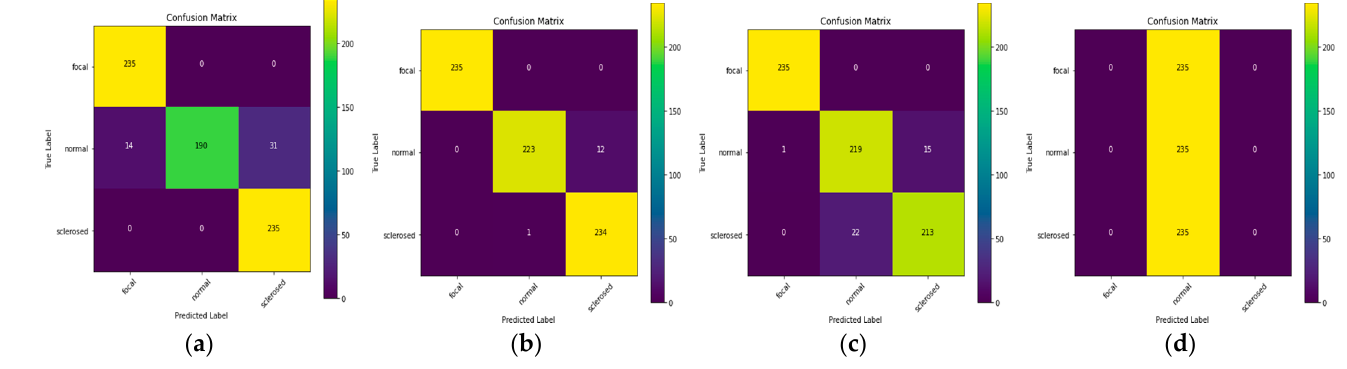
Figure 6. Confusion matrixes of various models. ( a ) VGG19; ( b ) ResNet101V2; ( c ) EfficientNet-B7 and ( d ) EfficientNet-L2.